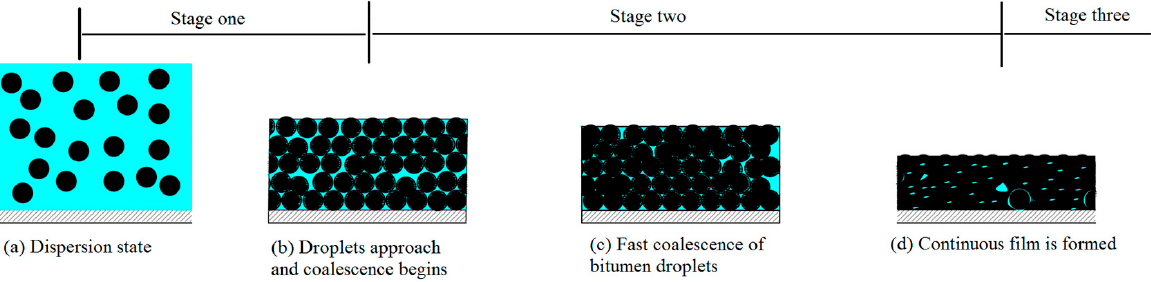
Figure 5. Schematic representation of the three-stage drying process .